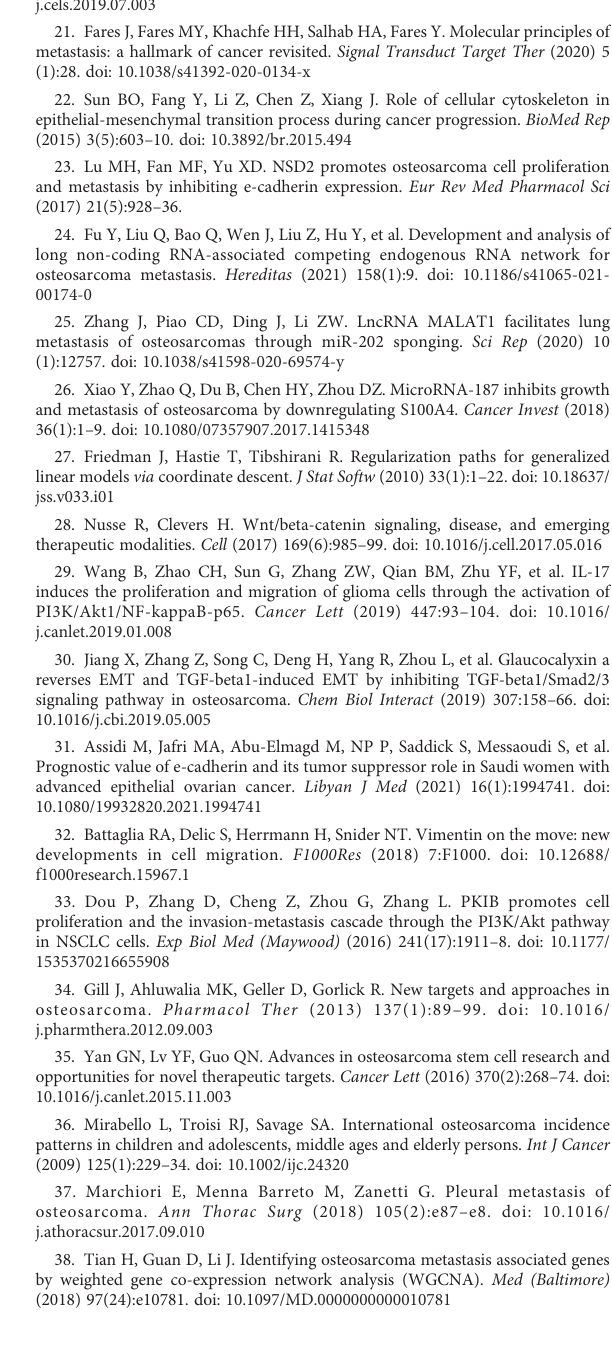
FIGURE S4 The expression of apoptosis related genes in 143-B cells with or without recombinant expression of PKIB. Q-PCR results to show the gene expression of Bcl-2 and